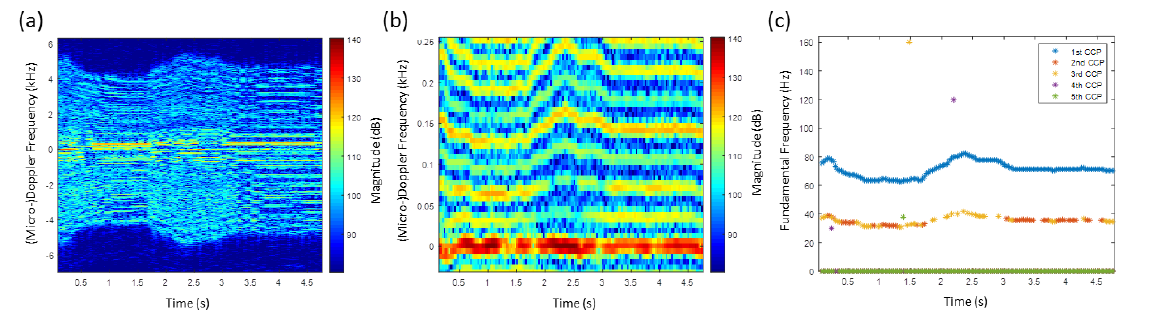
Figure 9. ( a ) HERM lines spectrogram for one-propeller helicopter measured by W-band radar; ( b ) zoomed into the HERM lines spectrogram showing individual HERM lines; ( c ) ccorresponding multi-frequency detector result.